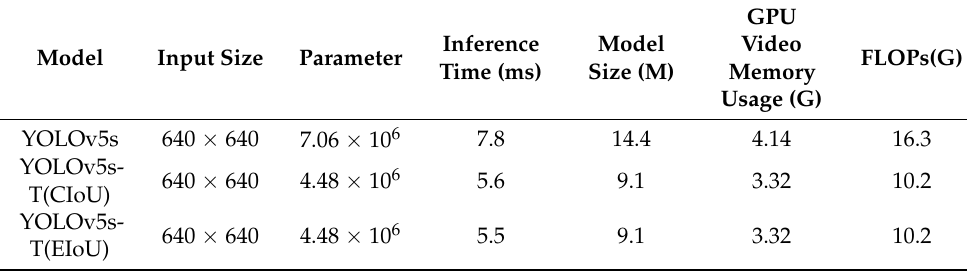
Table 2. Comparison of training metrics among different